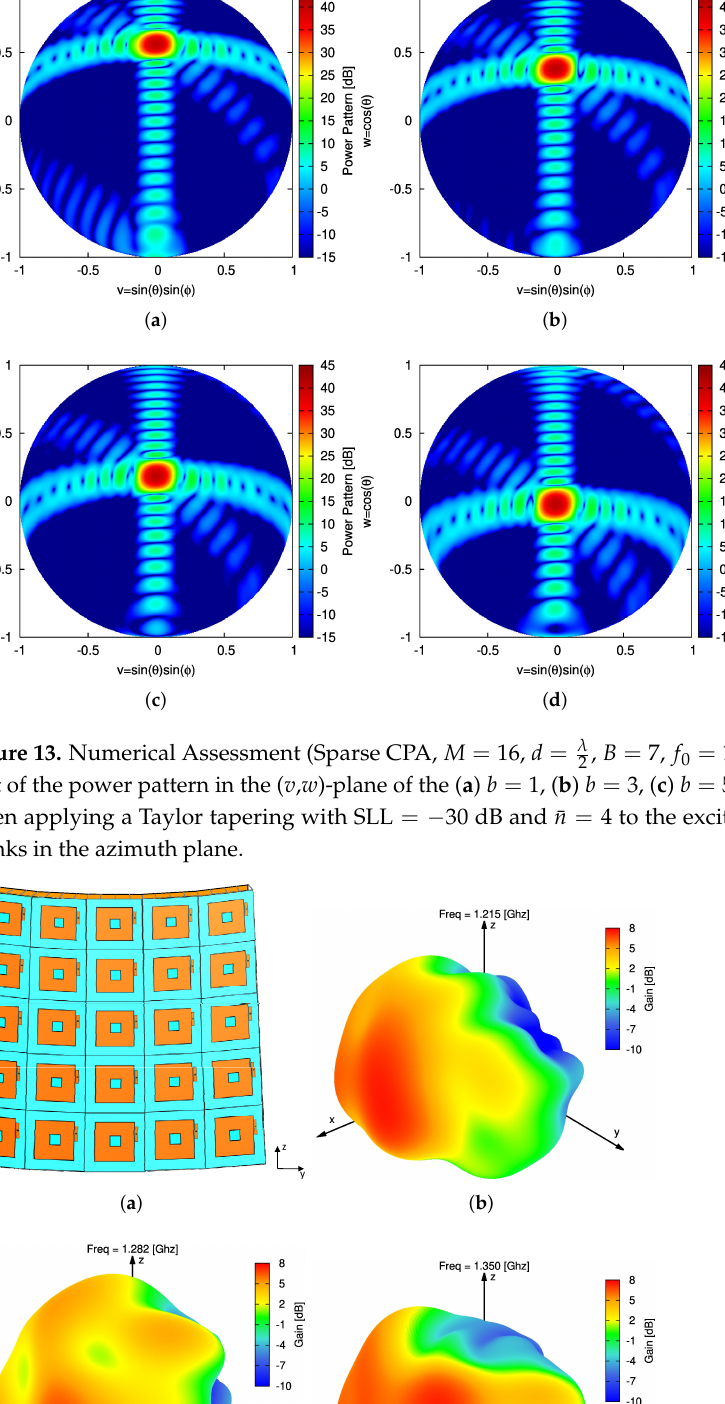
Figure 14. Numerical Assessment—Sketch of ( a ) the 5 × 5 conformal neighborhood antenna model used to compute ( b , c , d ) the embedded element pattern at ( b ) f min = 1.215 GHz, ( c ) f 0 = 1.282 GHz, and ( d ) f max = 1.350